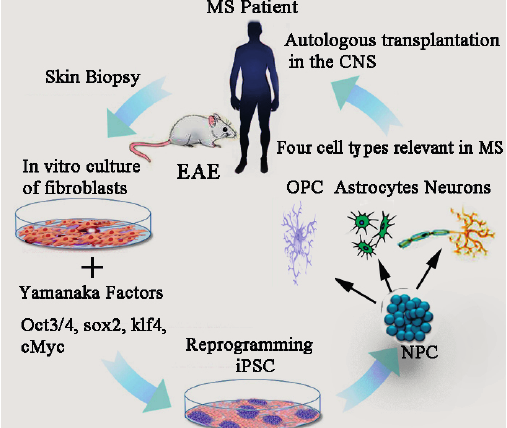
Figure 2. The scientific rationale behind human iPSC-based therapeutics. The underlying concept is that a patient’s own skin fibroblast cells could be epigenetically reprogrammed back into induced pluripotent stem cells. The primary dermal fibroblasts ( left image) from biopsy samples can be reprogrammed into iPSCs ( bottom image), which can be differentiated into NPCs, and subsequently into OPCs, neurons and astrocytes ( right image), and then autologously transplanted back into the original individual, at a low risk of immune rejection. The future goal of the iPSC-based cell therapy is to use iPSCs-derivatives to develop personalized neuroregenerative and immunomodulatory therapies. MS: multiple sclerosis; NPC: neural precursor cells; OPC: oligodendrocyte precursor cells; iPSCs: induced pluripotent stem